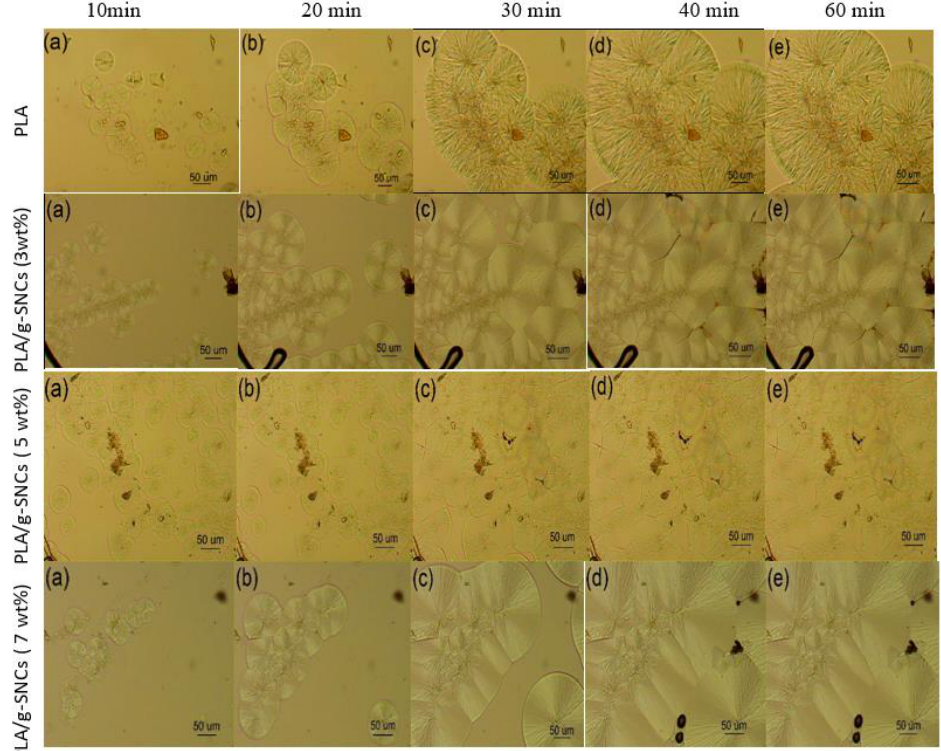
Figure 6. Optical microscopic images of neat PLA, PLA/SNC-g-LA (3 wt%), PLA/SNC-g-LA (5 wt%) and PLA/SNC-g-LA (7 wt%) nanocomposites at ( a ) 10 min, ( b ) 20 min, ( c ) 30 min, ( d ) 40 min, and ( e ) 60 min. Table 2. SAXS data of PLA and PLA/g-SNC nanocomposite which are crystallized at 130 °𝐶 and at various crystallization times.